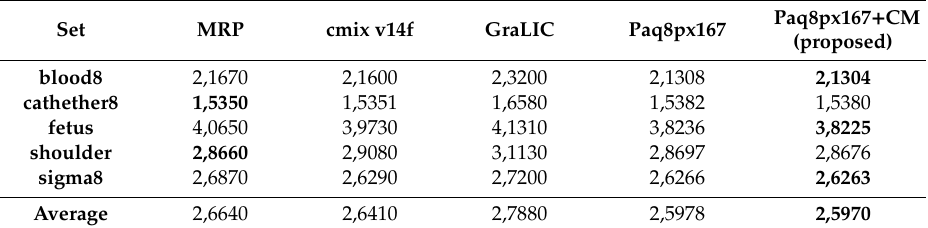
Table 4. Squeezechart 8 bpp grayscale.